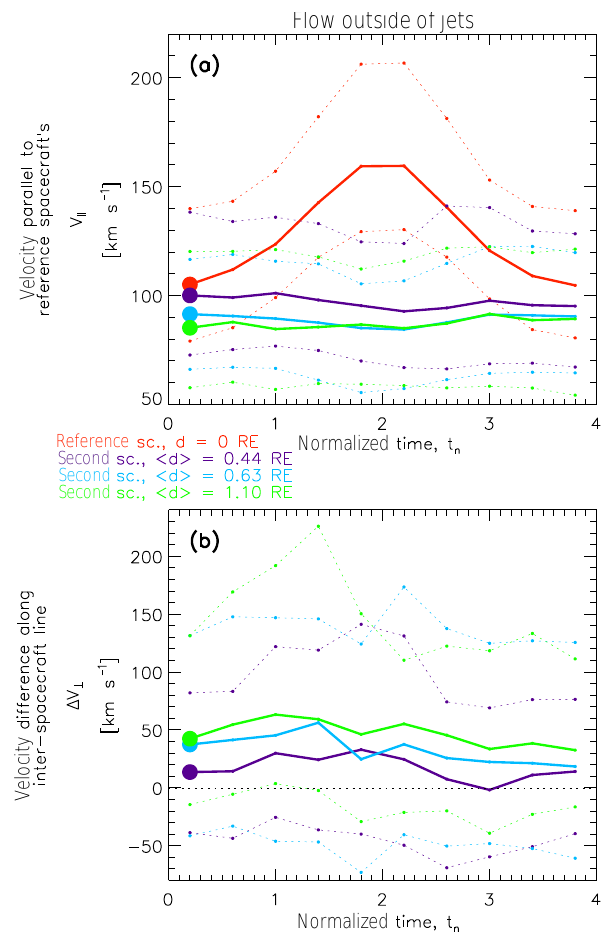
Figure 4. Cases where second spacecraft did not observe jets. The top panel (a) shows v (cid:107) and the bottom panel (b) shows (cid:49)v ⊥ val- ues. Median and (upper and lower) quartile values are depicted with solid and dotted lines, respectively. Red lines correspond to reference spacecraft measurements; purple, blue, and green lines correspond to second spacecraft measurements for (cid:104) d (cid:105) = 0 . 44 R E , (cid:104) d (cid:105) = 0 . 63 R E , and (cid:104) d (cid:105) = 1 . 10 R E , respectively. Initial median val- ues pertaining to normalized times t n = 0 ... 0 . 4 are depicted by bold